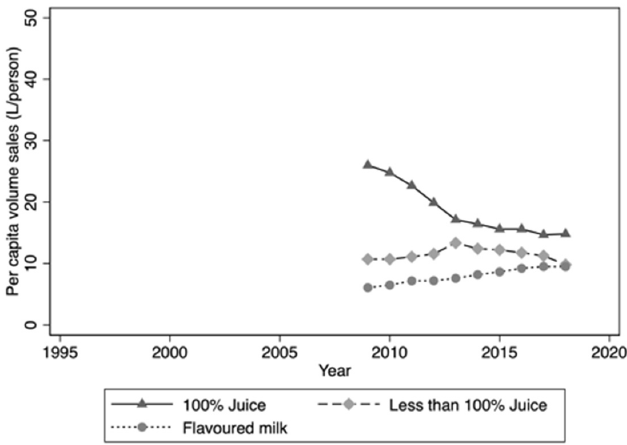
Figure 3. Per capita volume sales: Juice / juice drinks and flavoured milk drinks 2009–2018.